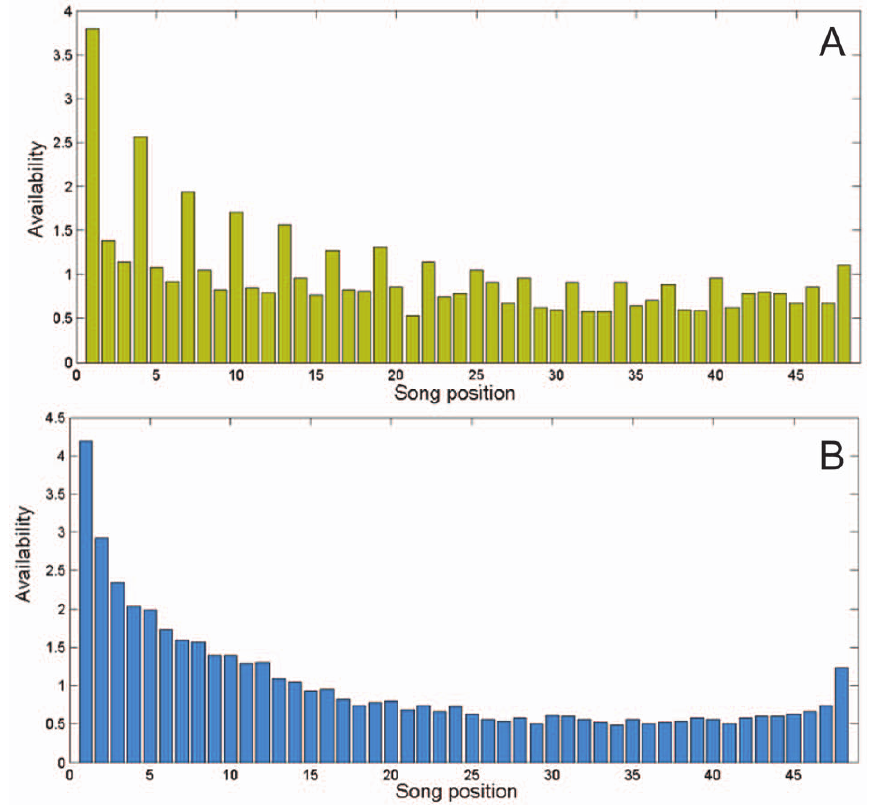
Figure 2. Availability in the independent world of Experiments 1 (A, top) and 2 (B, bottom), indexed to 1. The availability of a position n describes the likelihood that a song in that position will be sampled (where n=1 is the top left corner in Experiment 1, and the topmost position in Experiment 2, and n=48 is the bottom right corner in Experiment 1 and the bottom of the column in Experiment 2). Availability serves as a multiplier in calculating the total probability of a song being sampled, given its position-independent appeal, and its position at a given time in the market. In Experiment 1 (Figure 2a), songs on the left side of the grid are more likely to be sampled, all else equal, than songs on the right. In Experiment 2 (Figure 2b), songs at the top of the column, as well as the final song, are more likely to be sampled.